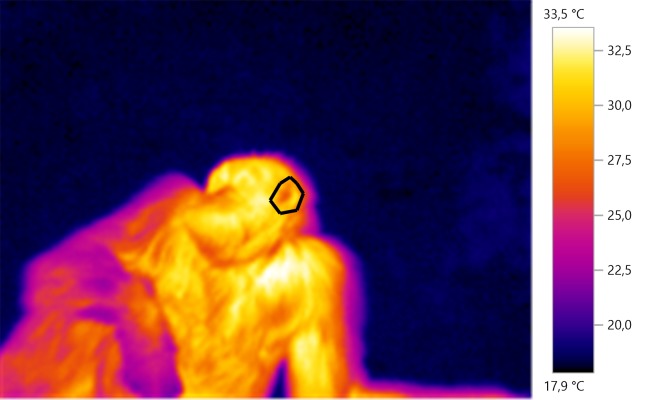
Example of IRT measurement.The polygon is drawn around the left ear of the individual which can be seen laying on the ground.